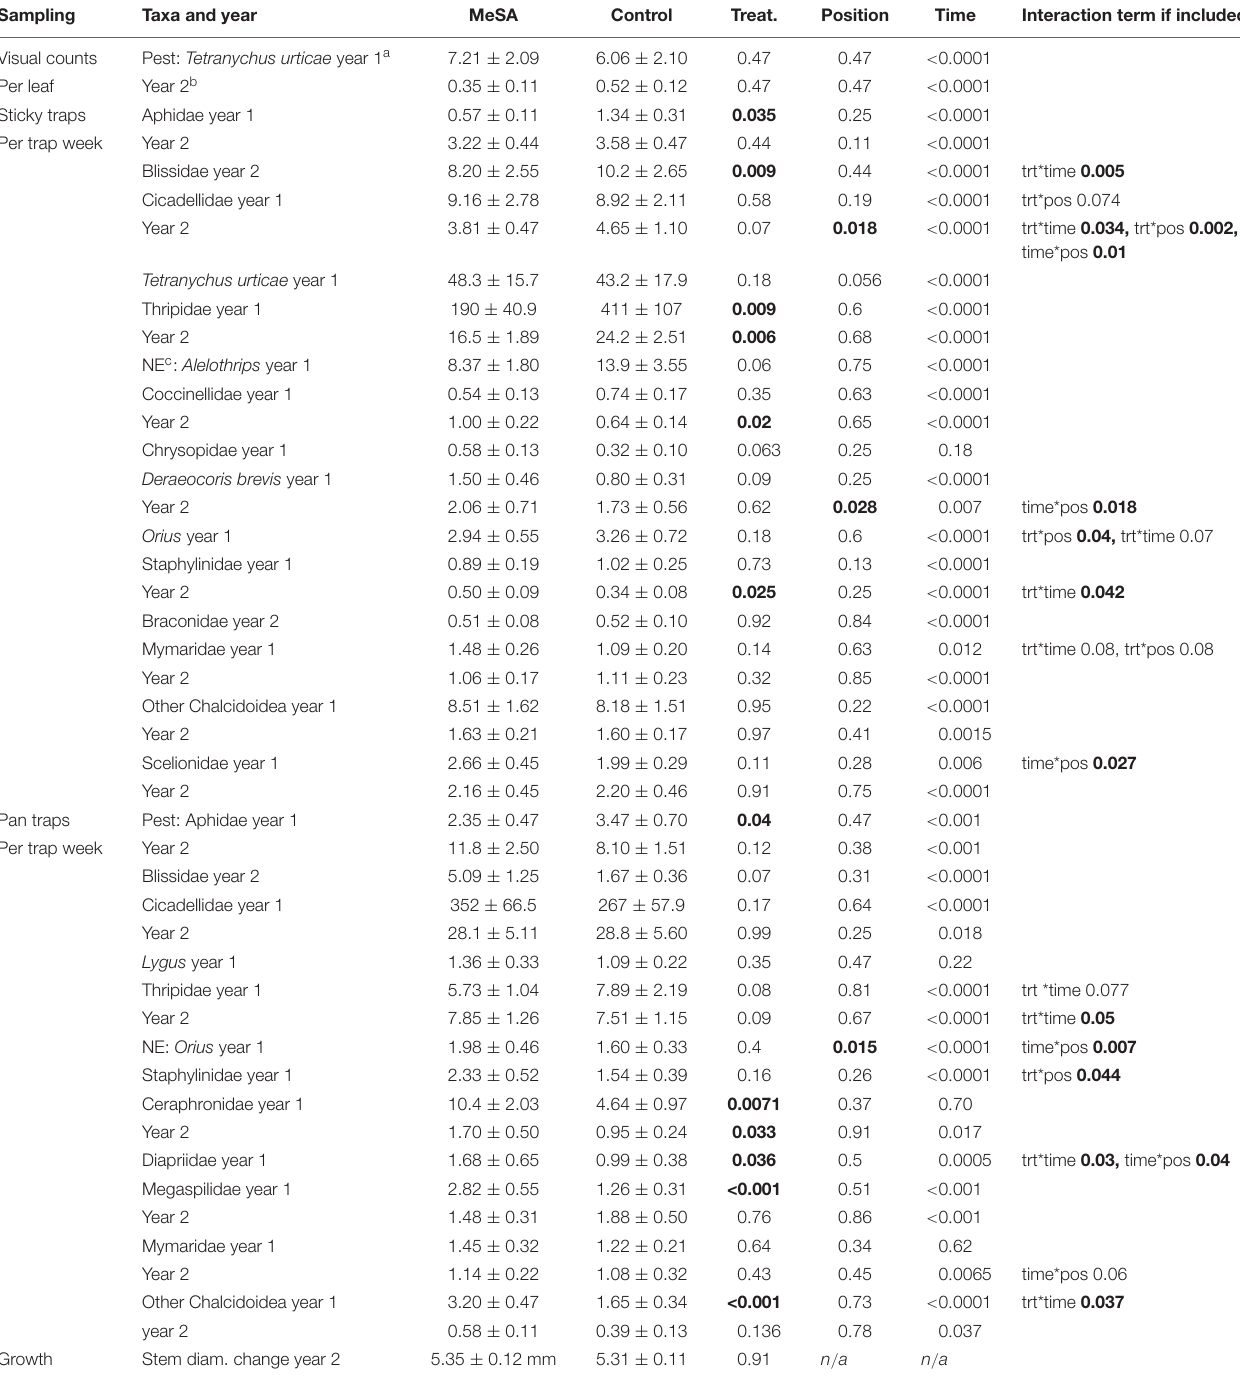
TABLE 3 | Mean ( ± SE) counts of insects in red maple plots with and without MeSA lures, and p -values from